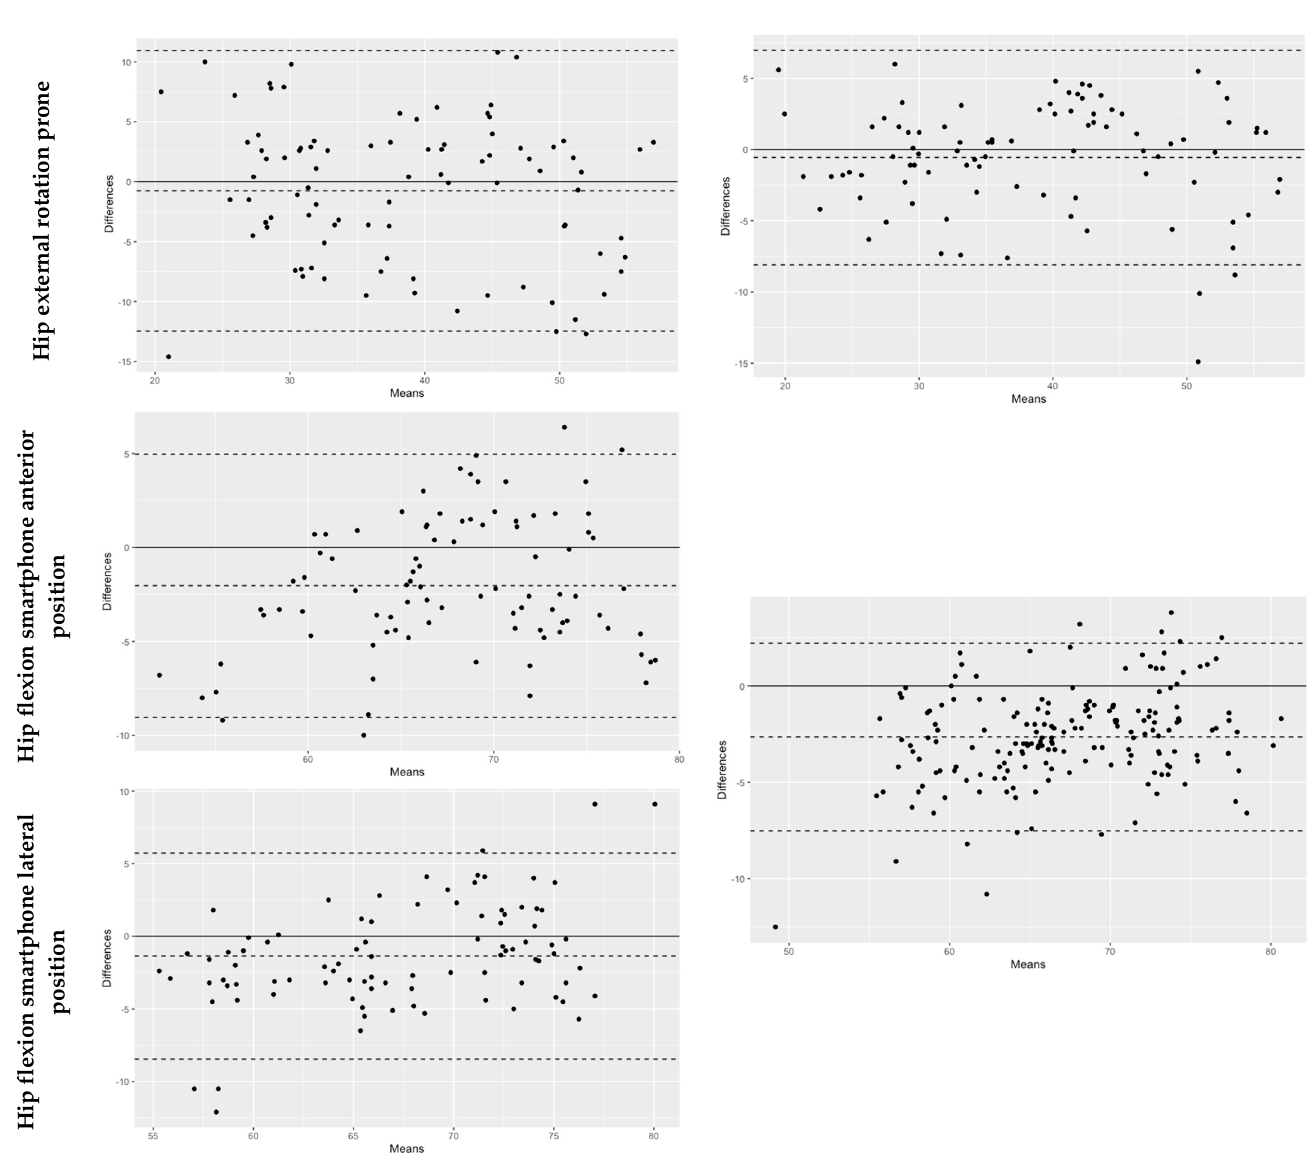
Figure 3. Bland-Altman plots showing agreement between TelePhysio and 3D measurements, and the agreement between Video and 3D measurements for hip range assessments. The y-axis represents the differences (degrees) between the two methods. The x-axis represents the means (degrees) of the two methods. The horizonal solid black line is zero. The horizontal middle dash line is the mean difference (bias) between the methods. The upper horizontal dash line is +1.96 upper limit, and the lower horizontal line is the -1.96 lower limit.